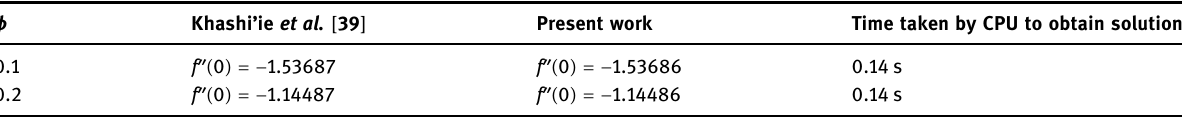
Table 3: Justi fi cation of the problem for f ″ ( 0 ) when Ma = 1 and λ = 1 ϕ Khashi ’ ie et al. [ 39 ] Present work Time taken by CPU to obtain solution